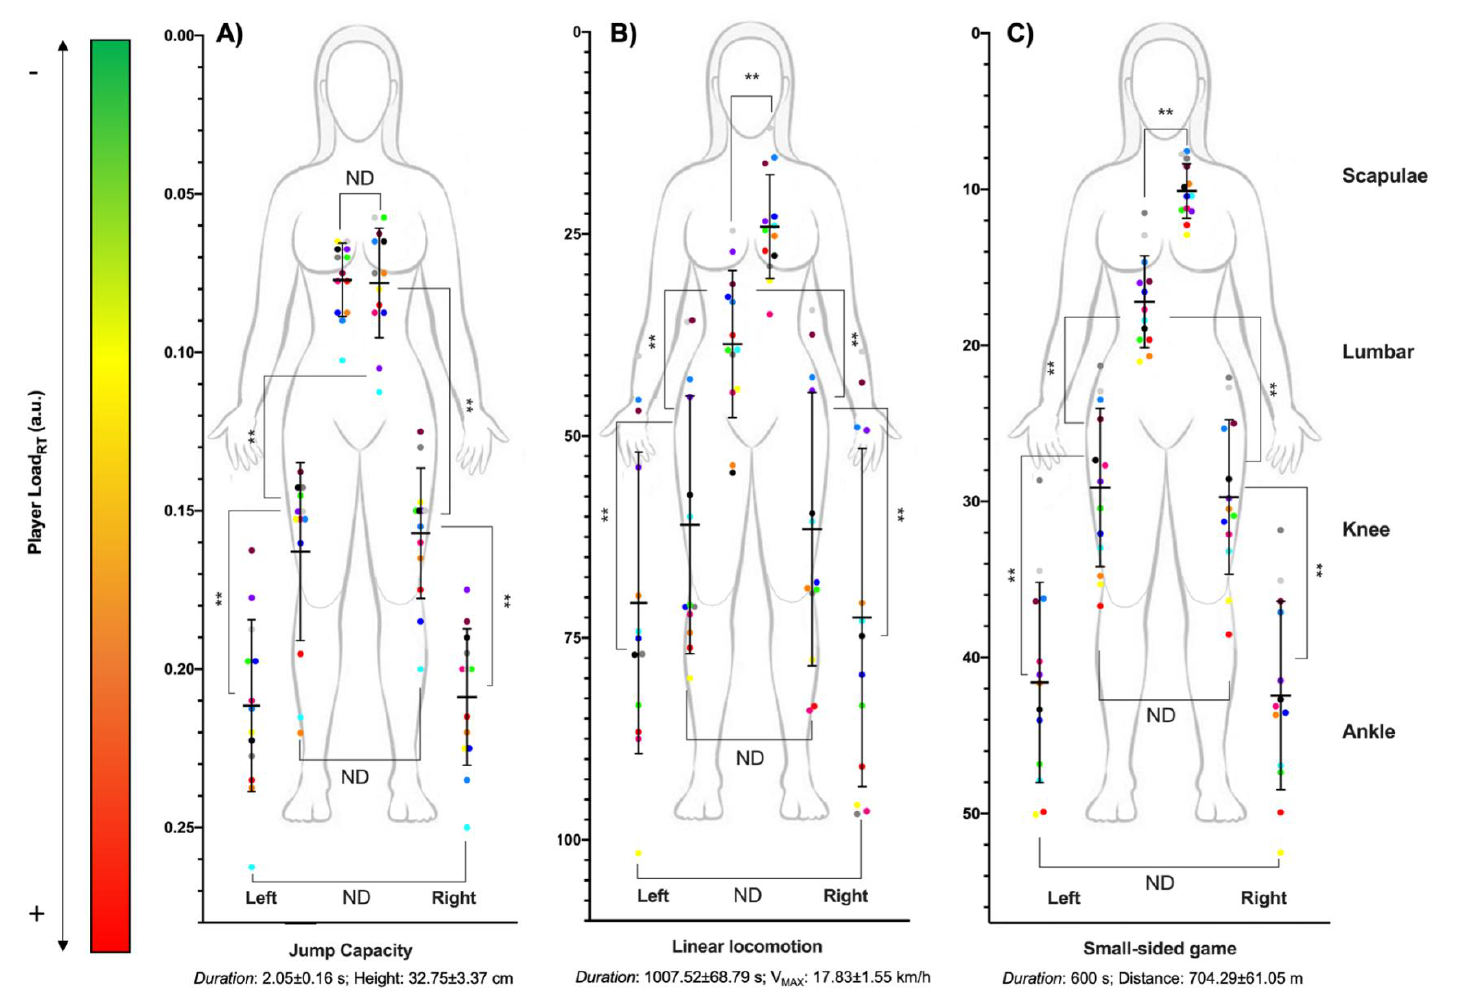
Figure 3. Multi-location external workload profile of semi-professional women’s basketball players in ( A ) jumps, ( B ) linear locomotion and ( C ) small-sided games. ** Statistical differences ( p < 0.01); ND: No statistical differences.